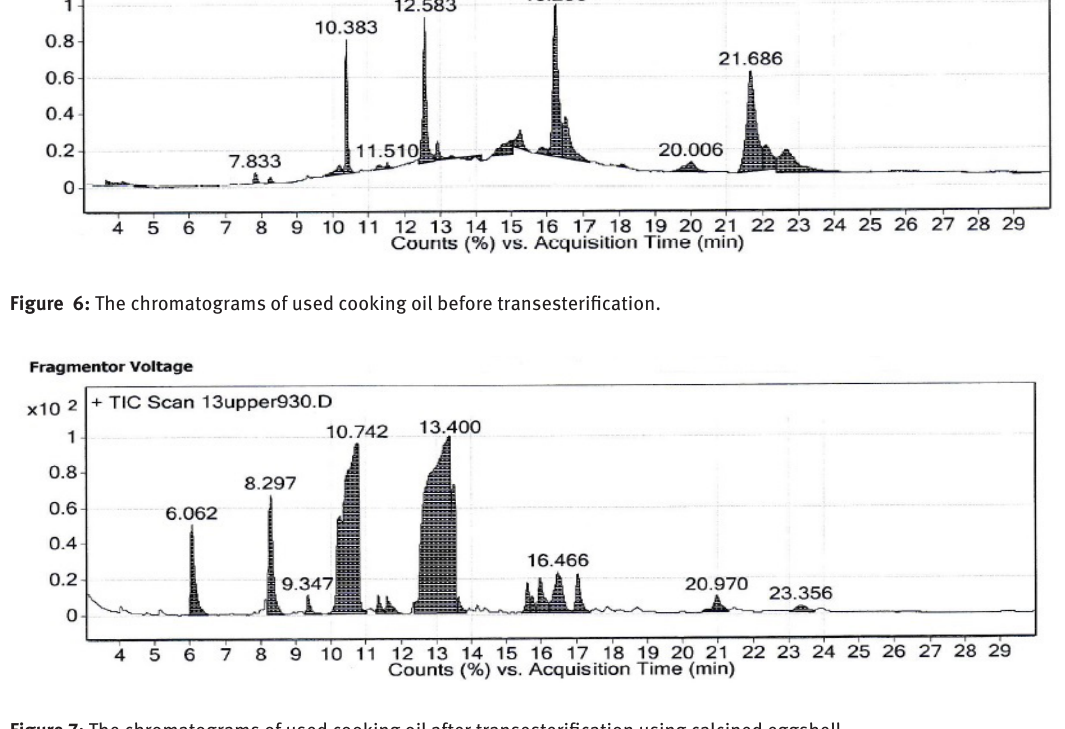
Figure 7: The chromatograms of used cooking oil after transesterification using calcined eggshell.